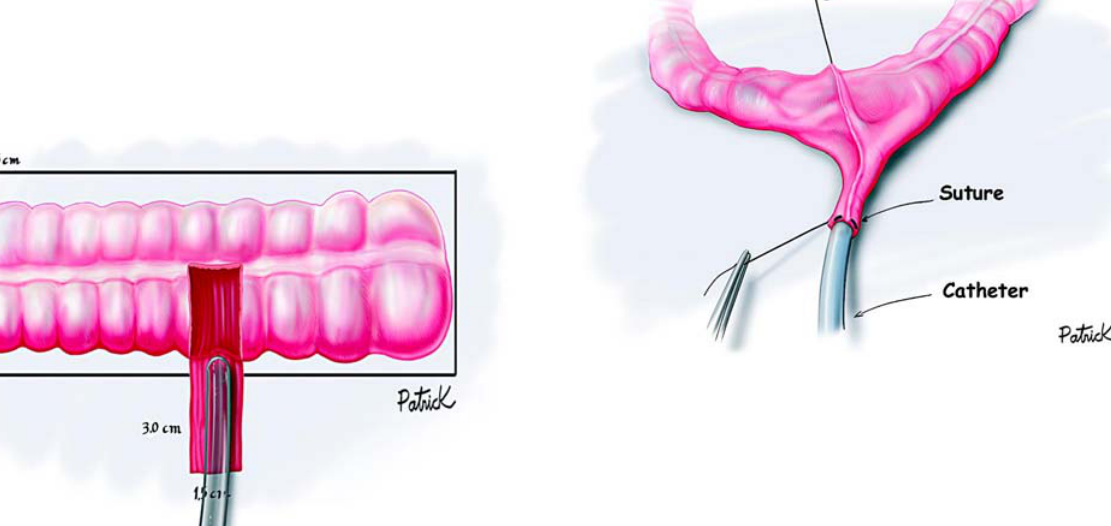
Figure 2 – Making of intestinal channel and repair of intestinal